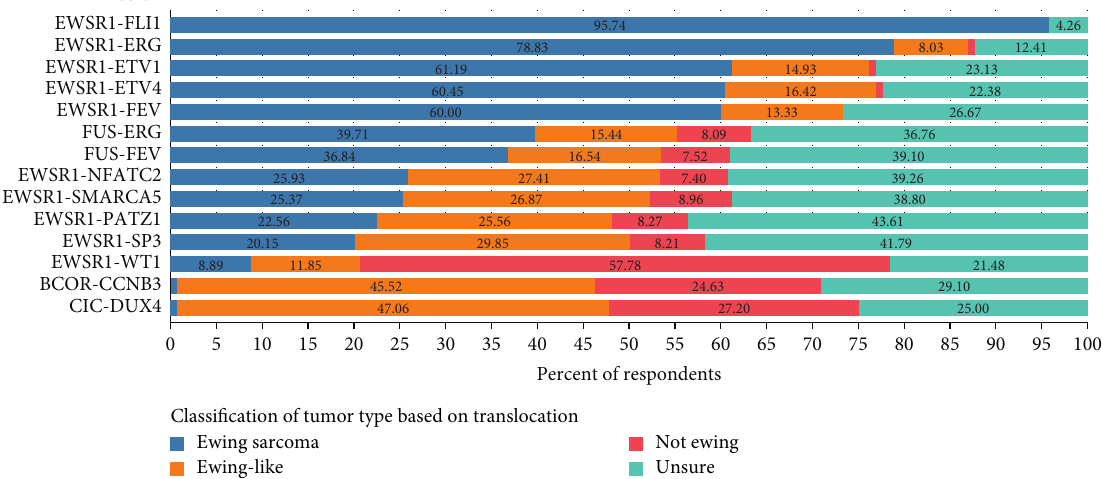
Figure 2: Classification of variant chromosomal translocations by percentage of respondents. The data represent the percentage of re- spondents who believed a given translocation in the column on the left represents Ewing sarcoma (blue bar and percentage), Ewing-like sarcoma (orange bar and percentage), not Ewing sarcoma (red bar and percentage), or unsure of the classification (teal bar and